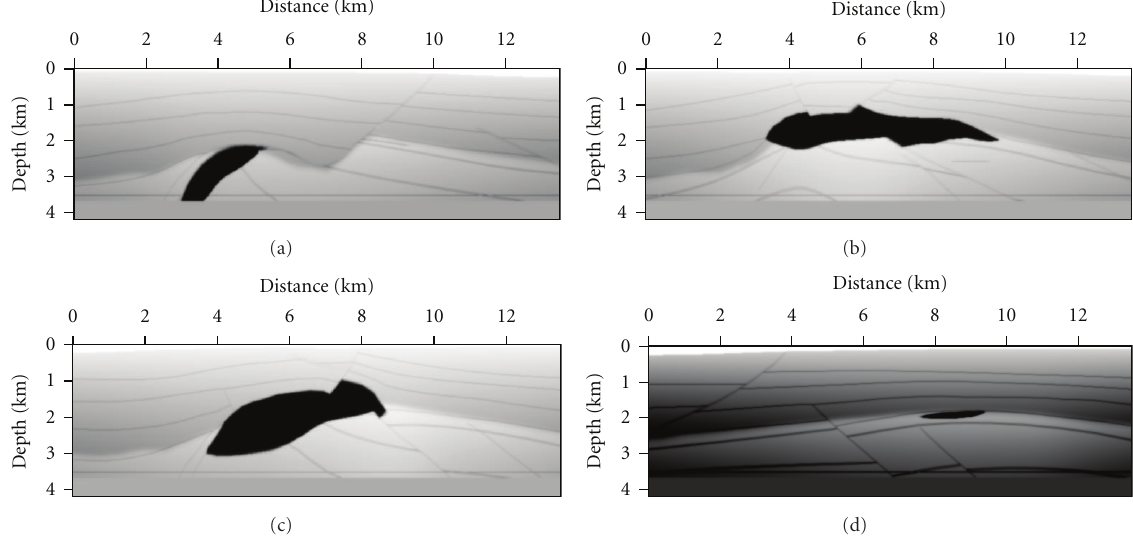
Figure 3: EAGE/SEG salt model. Representation by 4 vertical cuts at x = 4 . 14 km (a), x = 6 . 80km (b), y = 4 . 14km (c), and y = 10 . 22 km (d).